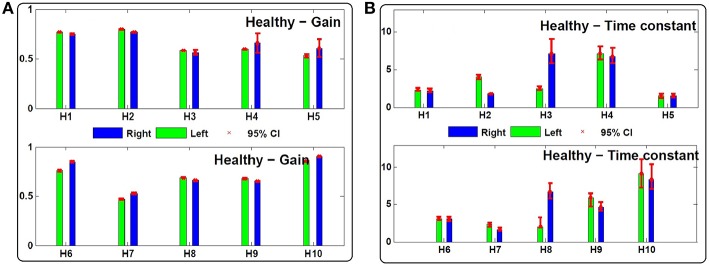
(A) Estimated gain (gl, gr) and (B) central processing time constant (Tl, Tr) values for leftward and rightward rotations in 10 control subjects (H1 − H10). Ninety-five percent confidence intervals of the estimated values are shown with red bars which are computed based on 200 Monte-Carlo studies as described in Section 2.2.